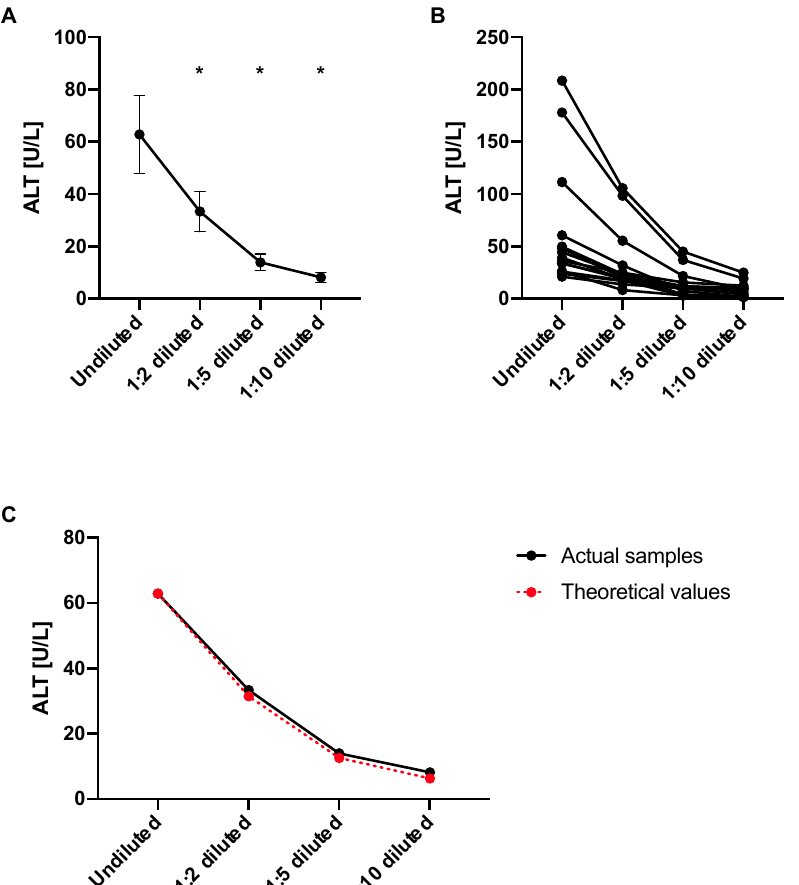
Figure 6. Decrease of ALT values of blood samples follows their dilution factor. Blood samples from mice ( n = 15) were obtained with EDTA (“plasma”) and diluted as indicated. ( A ) Average ALT levels for each group. ( B ) Separate ALT levels for each mouse by dilution factor. ( C ) Average ALT levels of actual samples in black compared with theoretical values in red. Results expressed as mean ± s.e.m. p values are determined by one-way paired ANOVA with Holm-Šídák’s post hoc test. * p < 0.05.